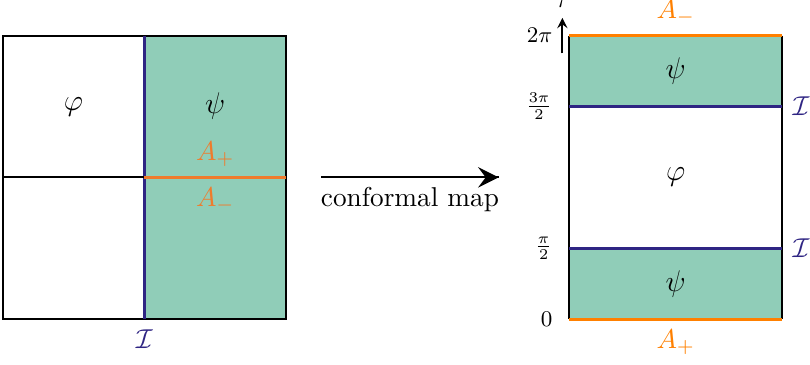
Figure 17 . The entanglement entropy across a conformal interface I (interface entropy) in two dimensions [Left]. The entangling region A is taken to be a half line right to the interface I . The configuration can be mapped to the cylinder by a conformal transformation